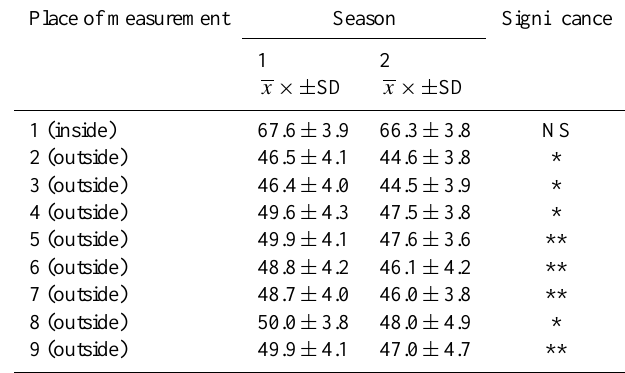
Table 2. Effect of season on noise levels. The sample size, N , was 45. Place of